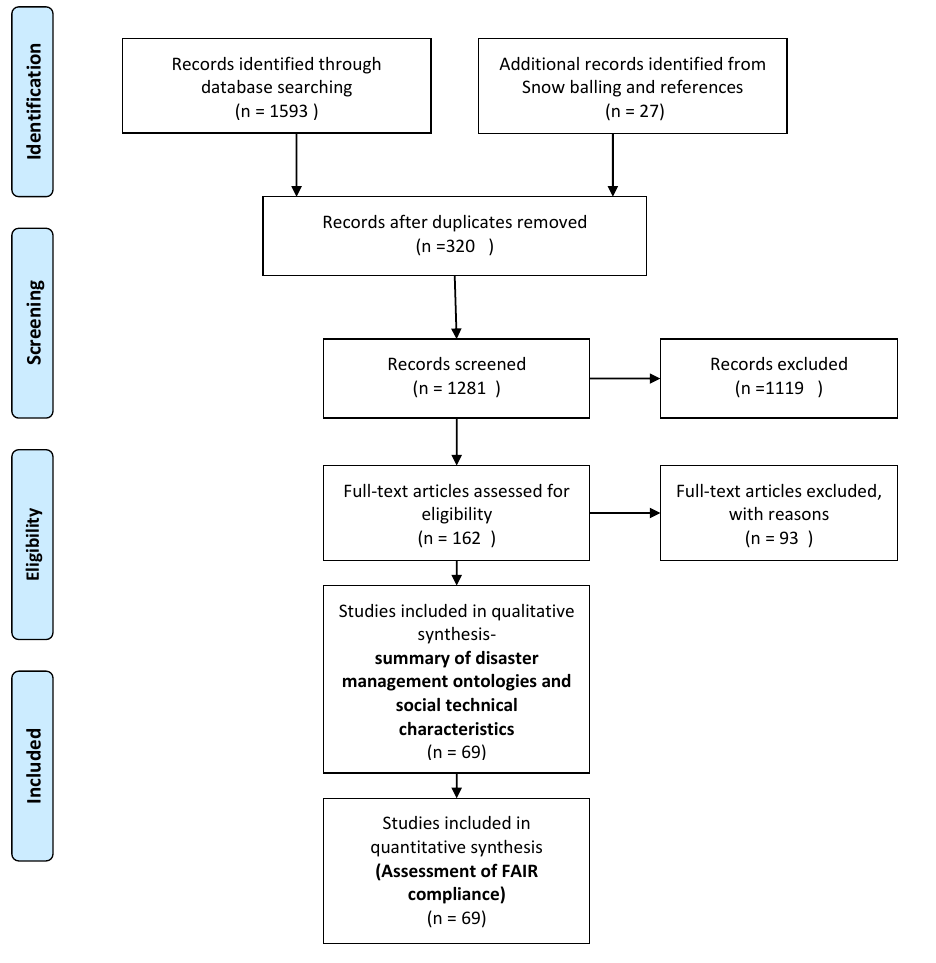
Figure 1. Search